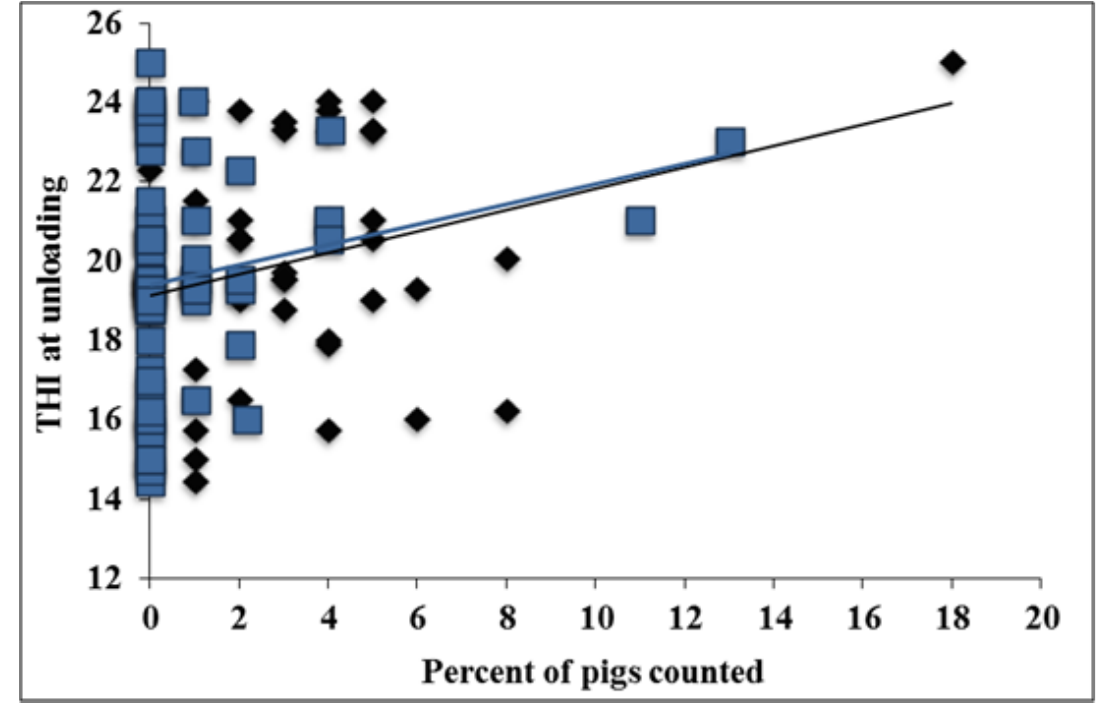
Figure 2. Experiment 1. Effects of temperature humidity index (THI) at unloading on vocalizations ( ◆ ) and stress signs ( ) at unloading including linear trend lines (respectively; p < 0.01, R 2 = 0.10; p = 0.04, R 2 =